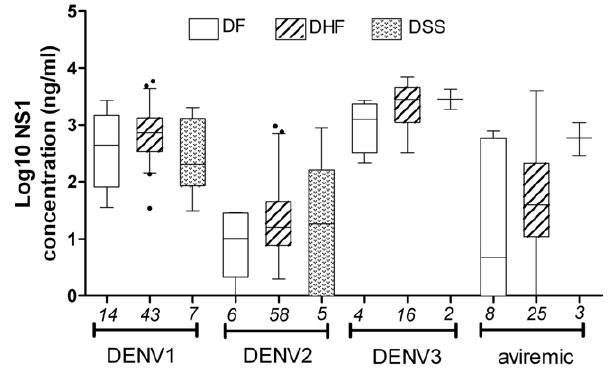
Figure 1. NS1 antigenaemia by disease severity. Shown are the median, interquartile and 95 th -percentile ranges of log 10 NS1 concentra- tion at enrolment, distributed by DENV serotypes and disease severity. Day of illness ranged from 3–9 and was comparable among DF, DHF, DSS groups. The number of patients in each group is shown in italics.